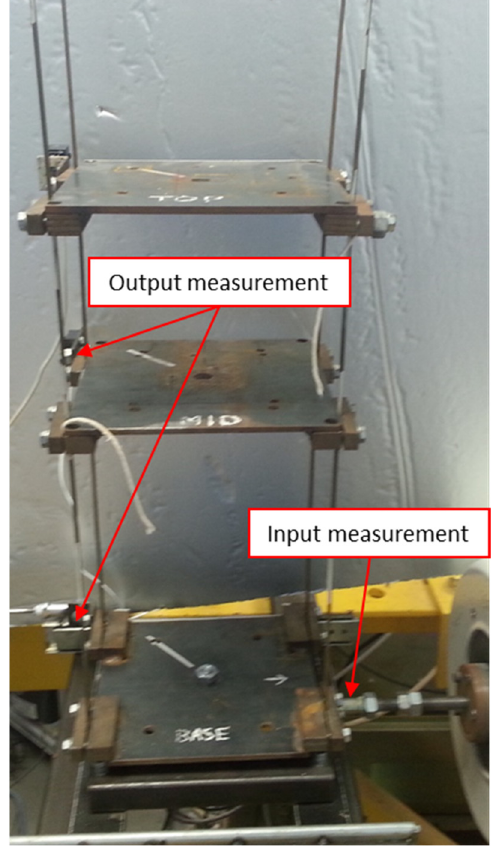
Figure 7. Three-floor building model and experimental set-up used for structural damage detection.